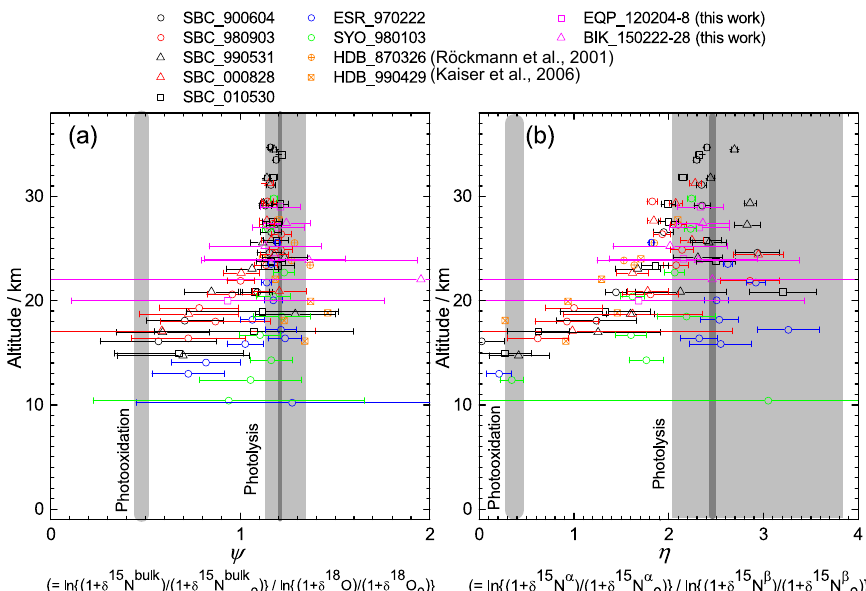
Figure 10. Vertical profiles of ratio of ε values for 15 N bulk and 18 O ( ψ) and the ratio of ε values for 15 N α and 15 N β ( η) calculated in the manner similar to that of Kaiser et al. (2006). Grey bands show values obtained by laboratory broadband photolysis experiments (Kaiser et al., 2002b, 2003) and photooxidation experiments (Kaiser et al., 2002a; Toyoda et al., 2004) with widths representing their uncertainty. For photolysis, uncertainties associated with temperature (190–240K) and wavelength (190–220nm) dependency are shown with dark and light grey,